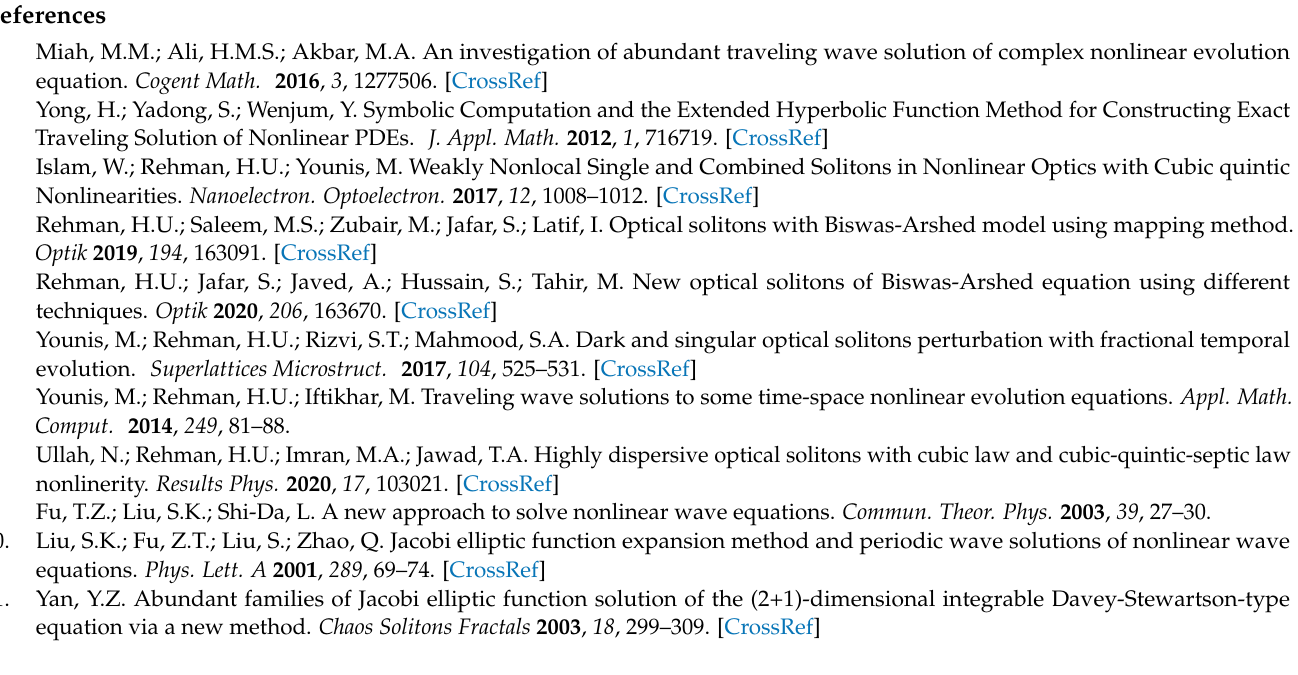
1, κ = 0, c = 1, p = − x 4 4; this represents the singular − ≤ ≤